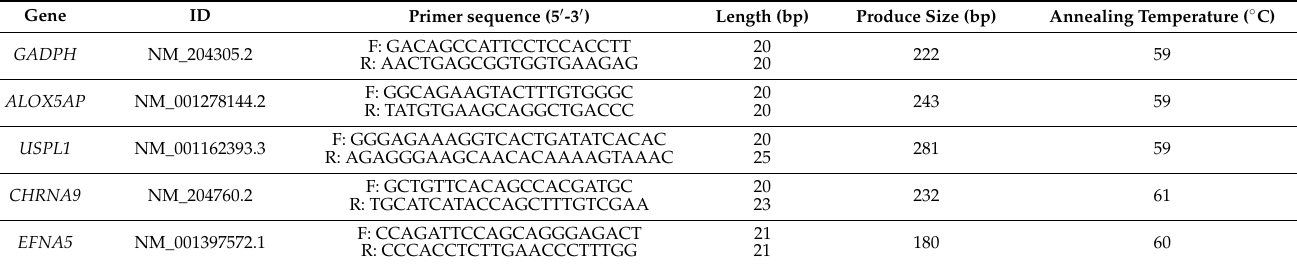
Table 3. qPCR primer information.